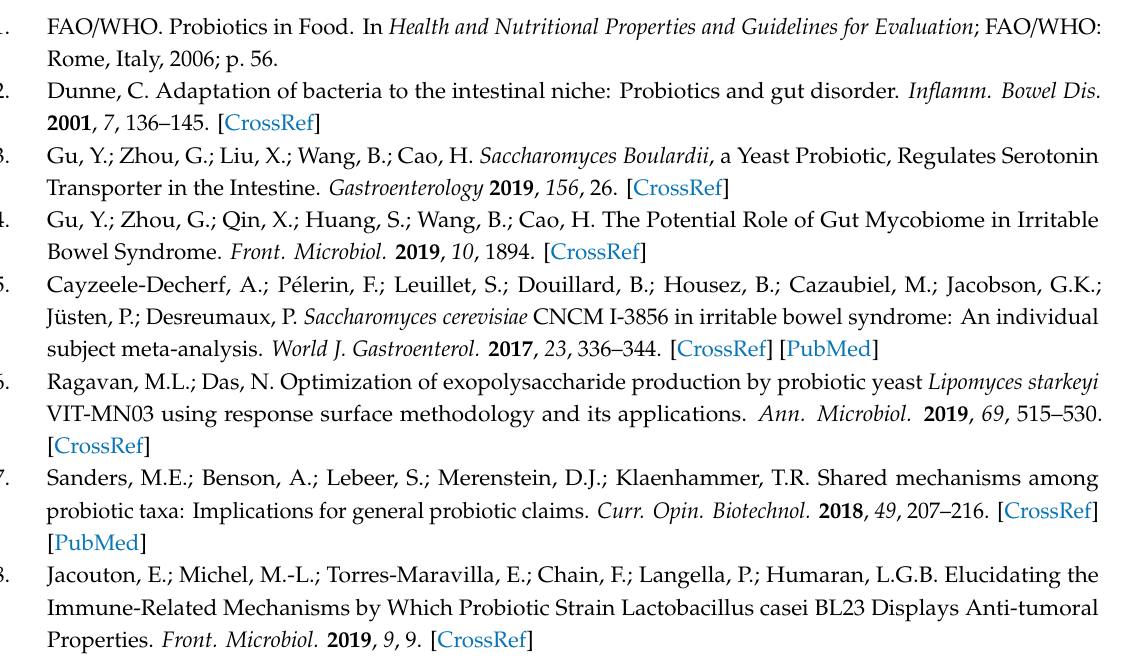
Table S1: Di ff erent works reporting the microencapsulation of